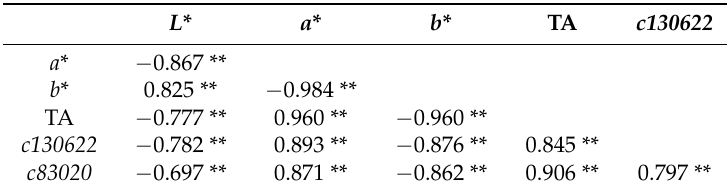
Table 4. Correlations between measurements of color, total anthocyanin content, and gene expression of variety C of Ranunculus asiaticus